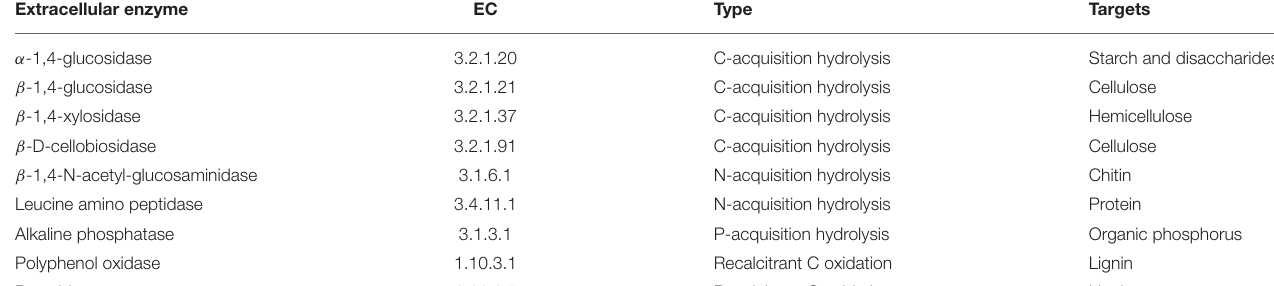
TABLE 1 | Description of soil extracellular enzymes in this study. Extracellular enzyme